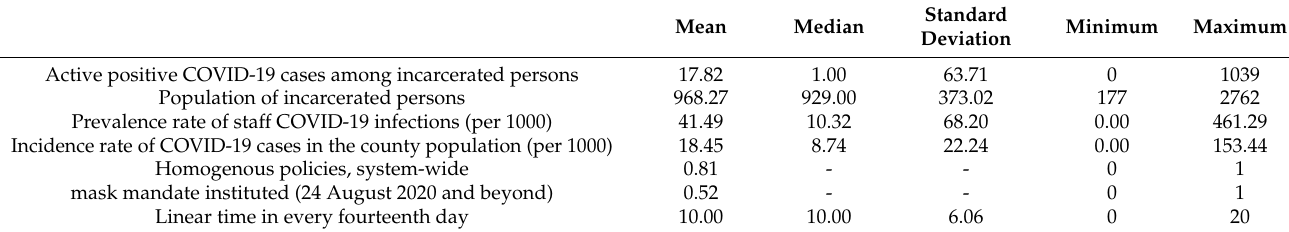
Table 1. Descriptive